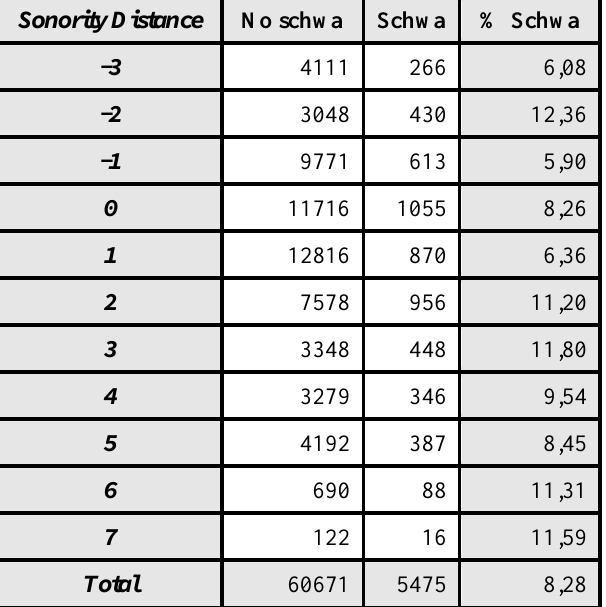
Table 8. Schwa realization rates as a function of Sonority